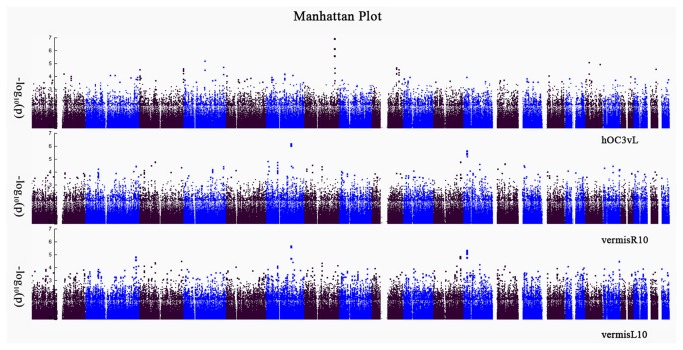
Manhattan plot for the Han Chinese genome-wide association study (GWAS) on schizophrenia using brain structure measures as a quantitative phenotype (Note: the points with red mean their P values >5x10-6).